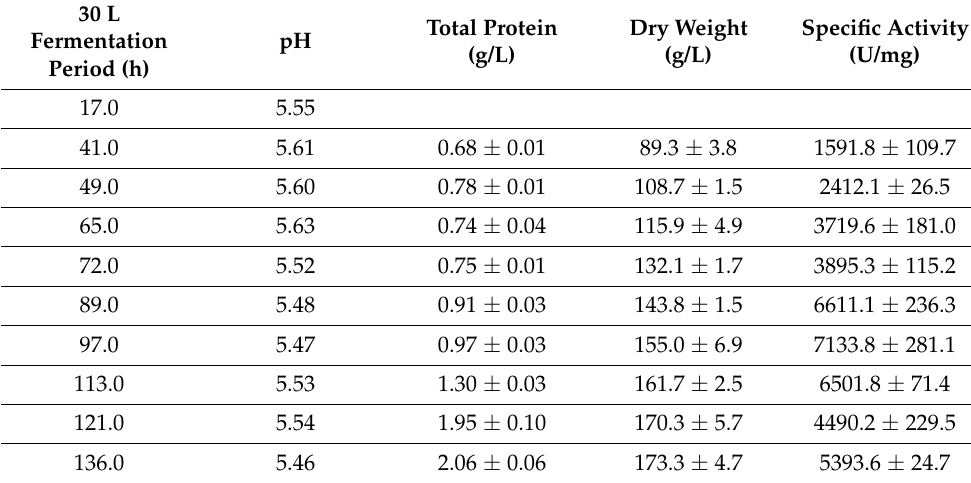
Table 1. Yield and specific activity during 30 L fermentation.